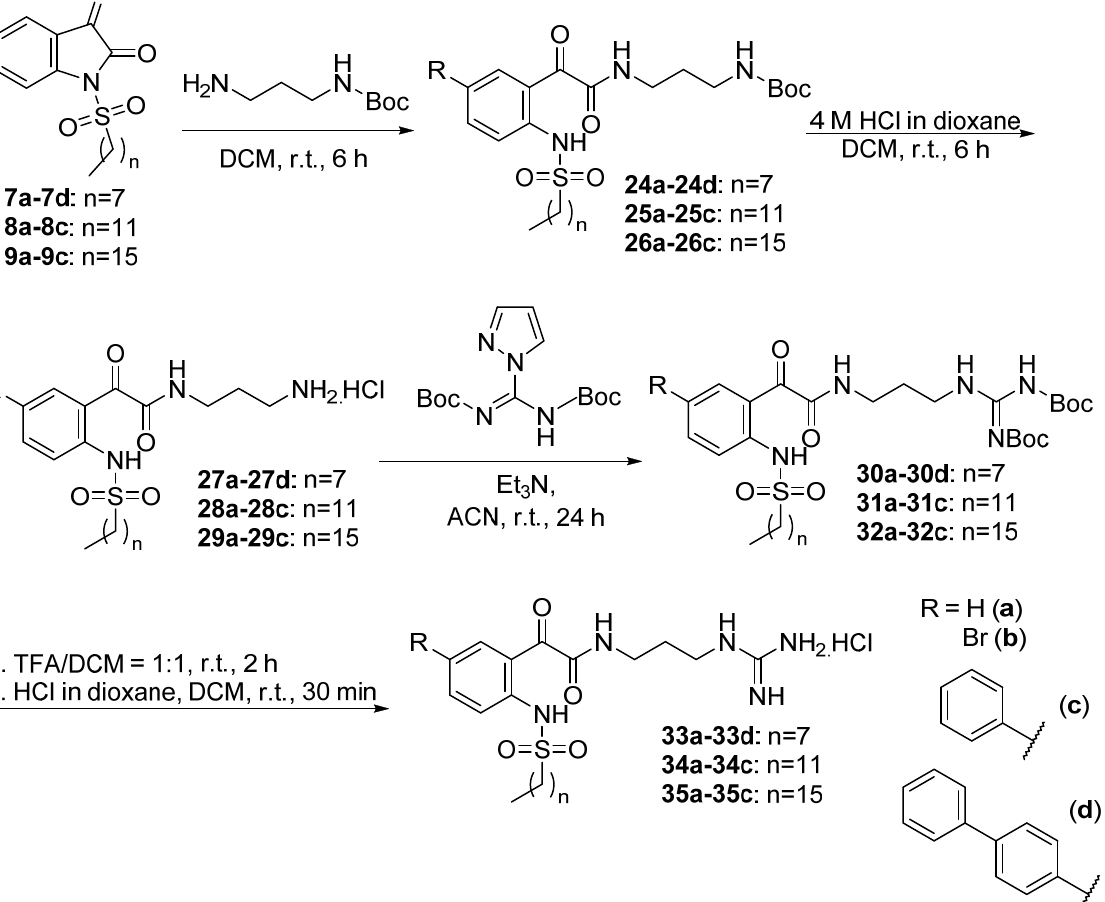
Table 1. Minimum inhibitory concentration (MIC) of peptidomimetics against S. aureus , E. coli and P. aeruginosa and the calculated AlogP values of peptidomimetics. Compound